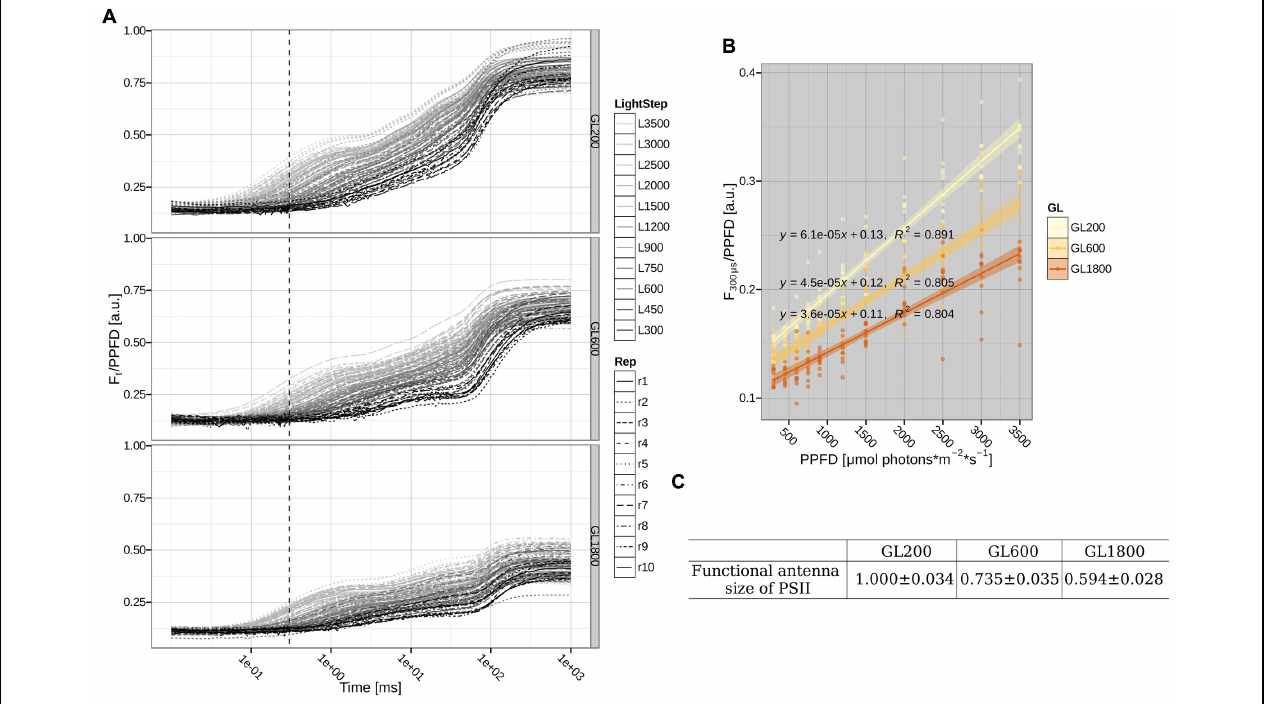
FIGURE 5 | Functional antenna size of PSII. (A) Direct measurements of chlorophyll a fluorescence in folio during a 1 s pulse of 300, 450, 600, 750, 900, 1200, 1500, 2000, 2500, 3000, and 3500 μ mol photons ∗ m − 2 ∗ s − 1 were normalized to the photosynthetic photon flux density (PPFD). The dotted, vertical line shows the 300 μ s time point. Shown traces for 10 different plants (Rep1-10, respectively, represented by different line types) grown under GL200, 600, and 1800 (respectively, Top, Central, and Bottom Left panels). (B) Relationship between normalized fluorescence at 300 μ s and PPFD fitted with a linear regression. The fitted lines with their standard error are shown as lines with shadows. Individual data points are from the plants grown under GL200, 600, and 1800, yellow, orange, and brown color, respectively. (C) The slope and standard error of a fit of the normalized fluorescence at 300 μ s against PPFD relationship corresponding to the functional antenna size of PSII on 10 different plants ( n = 10) grown under GL200, 600, and